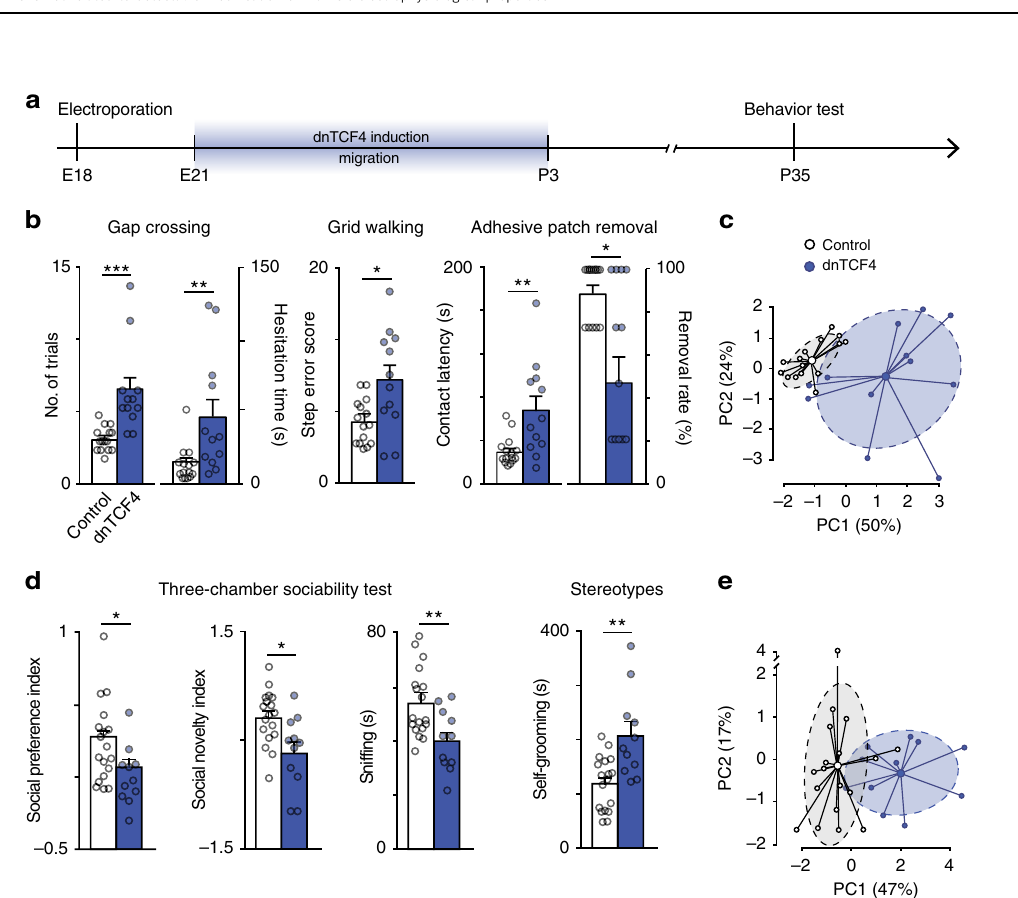
Fig. 6 Late arrival of CPNs leads to long-term de fi cit of sensory function and social behavior. a Experimental timeline. b Sensory-oriented behavior tests show de fi cit in adult rats with delayed CPN migration; n = 15 and 12 animals (Control and dnTCF4, respectively), Mann – Whitney. c Principal component (PC) analysis of variables from sensory tests separates animals with late-arrived neurons (dnTCF4) from controls. d Decreased sociability and interaction (snif fi ng) as well as increased tendency for repetitive movements (self-grooming) in animals with late-arrived CPNs; n = 18 and 11 animals (Control and dnTCF4, respectively), Mann – Whitney. e Plots of PC analysis of autistic-like variables. Graphs display mean ± s.e.m. * P < 0.05, ** P < 0.01, *** P <